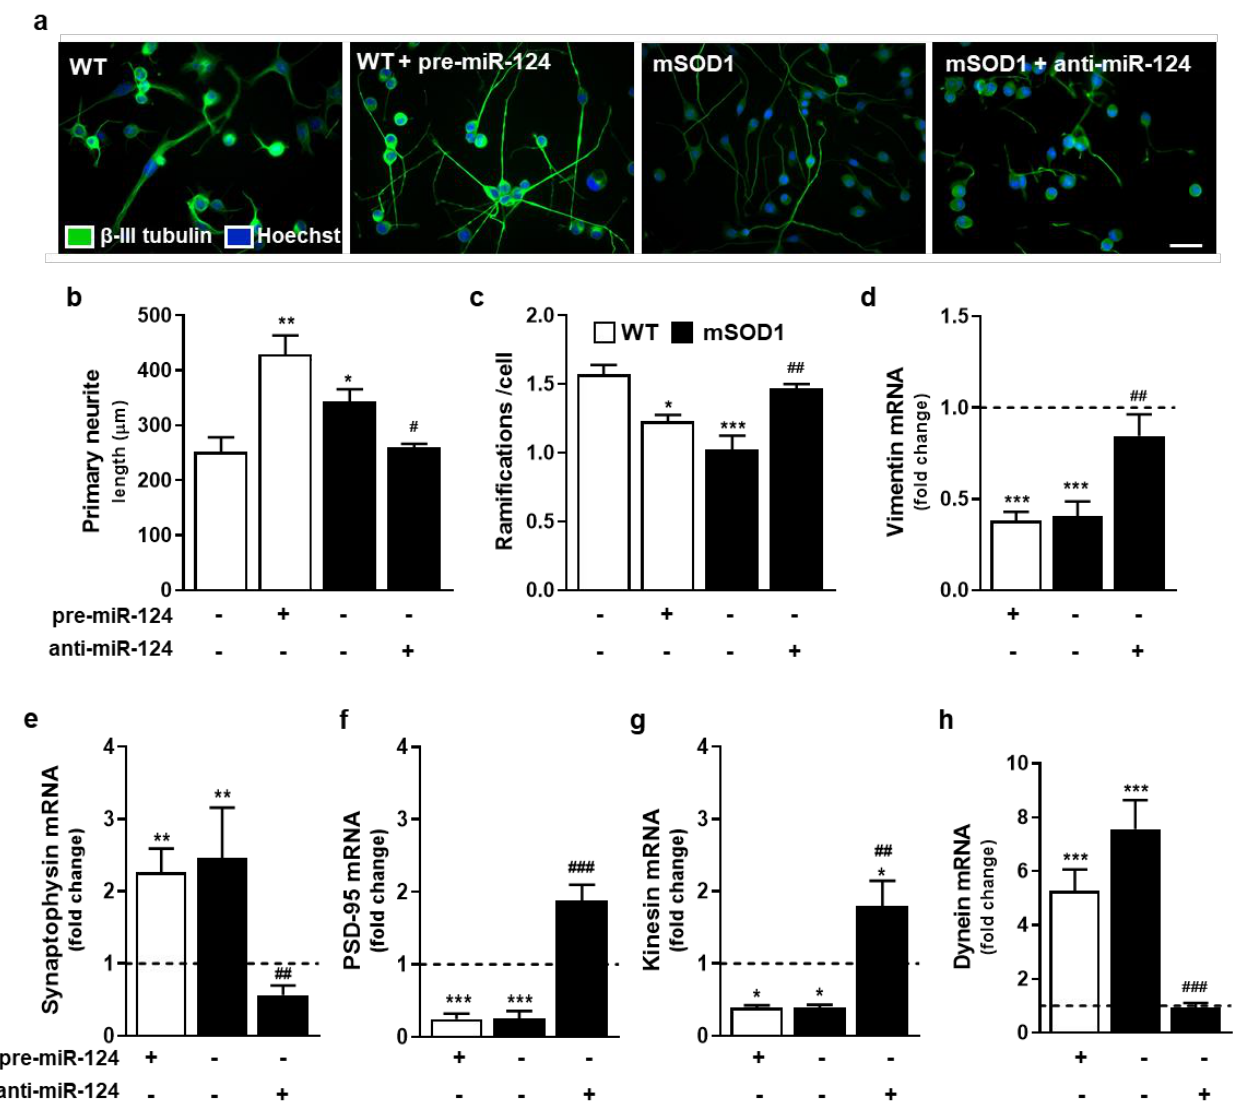
Figure 3. Impaired neuronal arborization, trans-synaptic signaling, and axonal function by elevated levels of miR-124 in MNs is abolished by anti-miR-124 treatment of mSOD1 MNs. After 2 days of differentiation, NSC-34 (wild type, WT) MNs and mSOD1 MNs were transfected with pre-miR-124 or anti-miR-124, respectively, for 12 h and maintained for additional 48 h. After this period, cells were collected for ( a – c ) immunostaining analysis or ( d – h ) mRNA isolation. MNs were stained with an antibody to β-III tubulin and ( a ) representative images of each condition are shown. ( b , c ) Neurite length and ramification number were measured by using NeuroJ (plug-in from ImageJ software). Further, ( d ) vimentin, ( e ) synaptophysin, ( f ) PSD-95 (Dlg4 gene), ( g ) kinesin (Kif5b gene), and ( h ) dynein mRNA levels were evaluated by reverse transcriptase quantitative real-time PCR (RT-qPCR). β-actin was used as the reference gene. Results are mean ± SEM from at least 6 independent experiments and expressed as fold change vs. WT MNs (dashed line). *** p < 0.001, ** p < 0.01, and * p < 0.05 vs. WT MNs; ### p < 0.001, ## p < 0.01, and # p < 0.05 vs. mSOD1 MNs; one-way ANOVA followed by multiple comparisons Bonferroni post-hoc correction. Scale bar: 20 μm. MNs, motor neurons; mSOD1, MNs overexpressing G93A mutation in superoxide dismutase 1; PSD-95, post-synaptic density protein 95; WT, wild type.